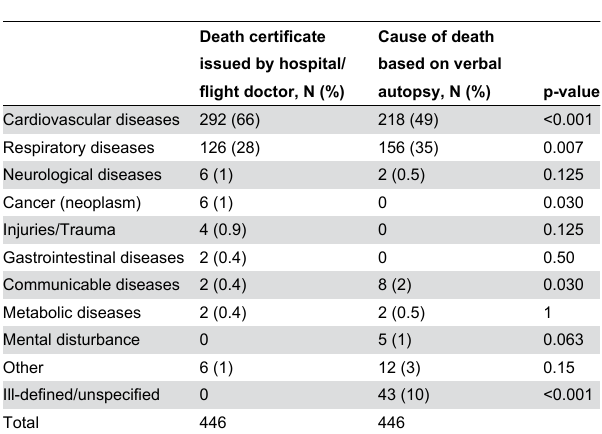
Table 3. Comparison of cause of death according to hospital/flight doctor death certificate and verbal autopsy method,